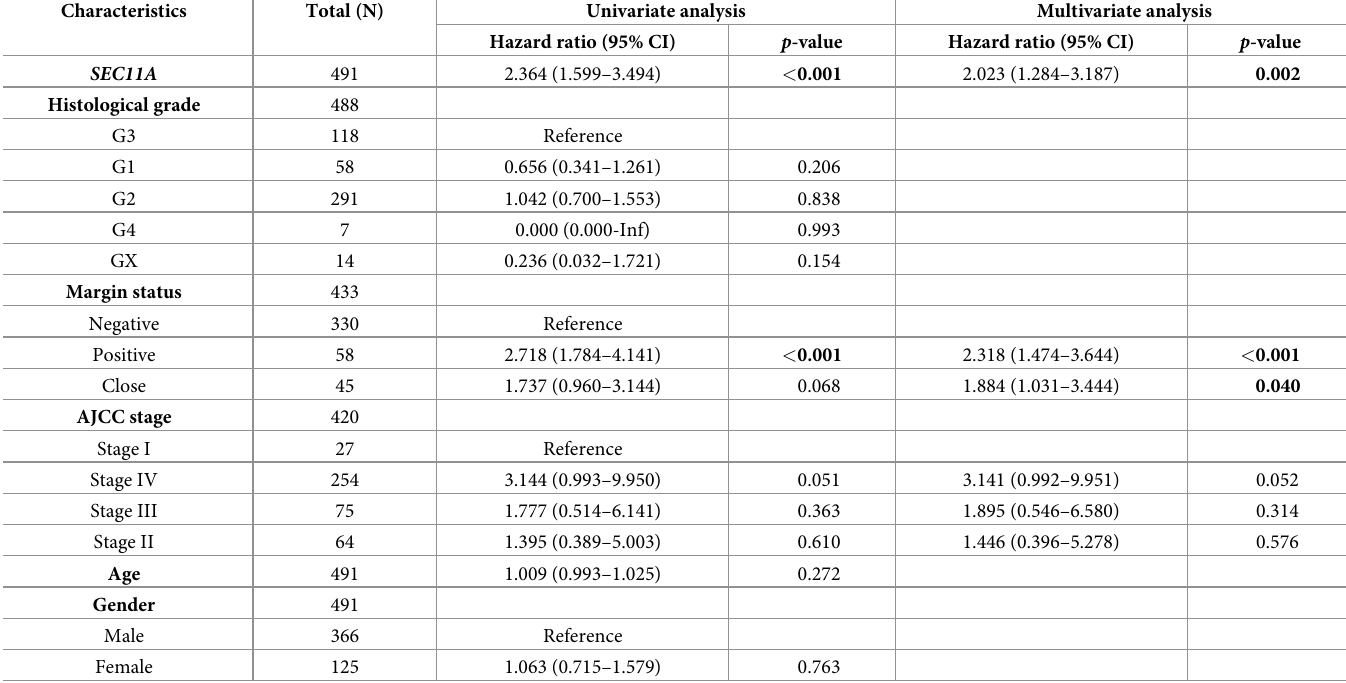
Table 3. Univariate and multivariate analysis for